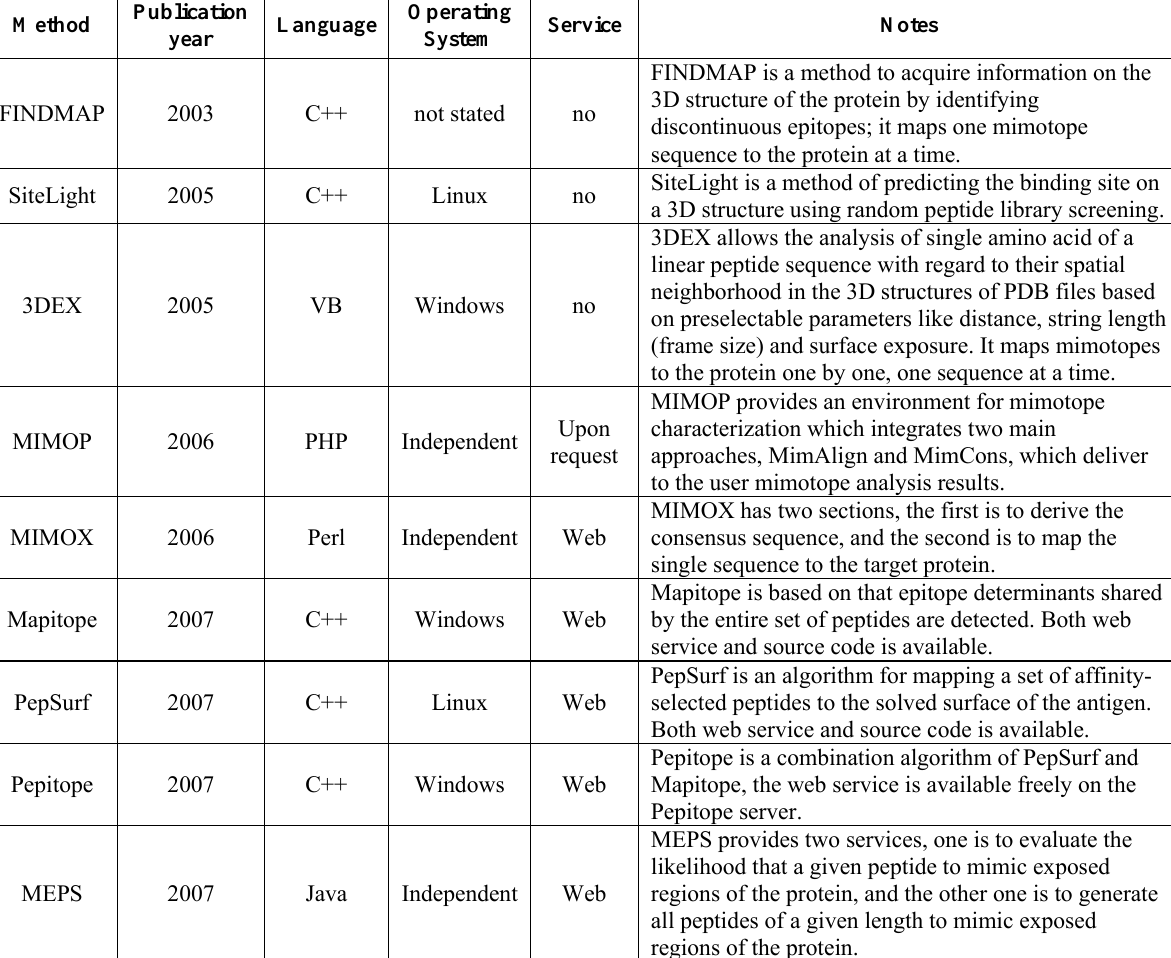
Table 1. Comparison of 11 epitope prediction methods. A brief introduction was